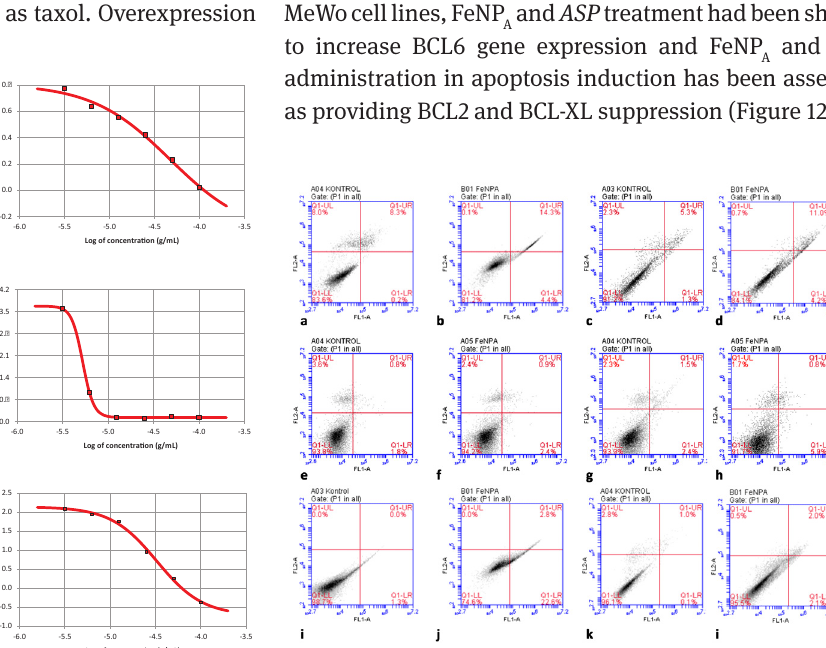
Figure 10: Apoptotic effect of FeNP value of FeNP were determined. (a) IC was fold in MCF-7 cells, (d) 2.31 fold in MDA-MB-231, (f) 1.29 fold in CHL-1 Figure 9: IC 50 A 50 139.40 µg/mL in MCF-7, (b) 47.00 µg/mL in MDA-MB-231, cells, (h) 1.72 fold in MeWo cells, (j) 19.85 fold in WI-38 cells and (c) in MeWo38.48 µg/mL, (d) 5.26 µg/mL in CHL-1, (e) 179.12 µg/mL (l) 3.71 fold in HEL 299 cells compared to the control group (a, c, e, g, in WI-38 and (f) 32.70 µg/mL in HEL 299. i and k are untreated control groups of the cell lines,